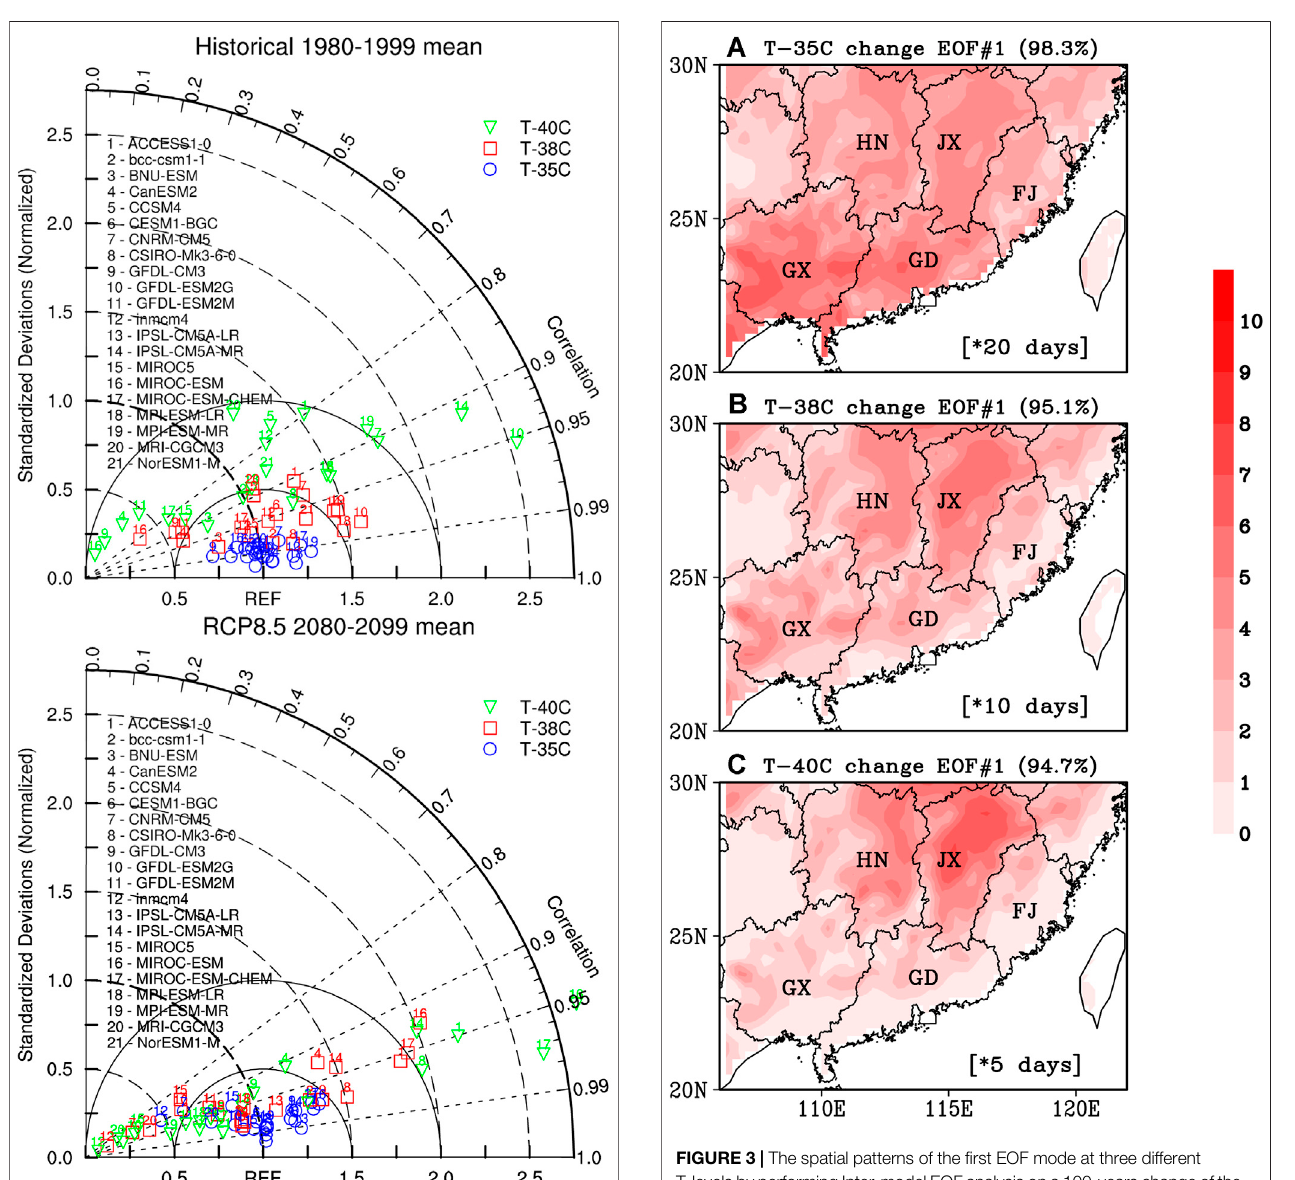
Frontiers in Earth Science |